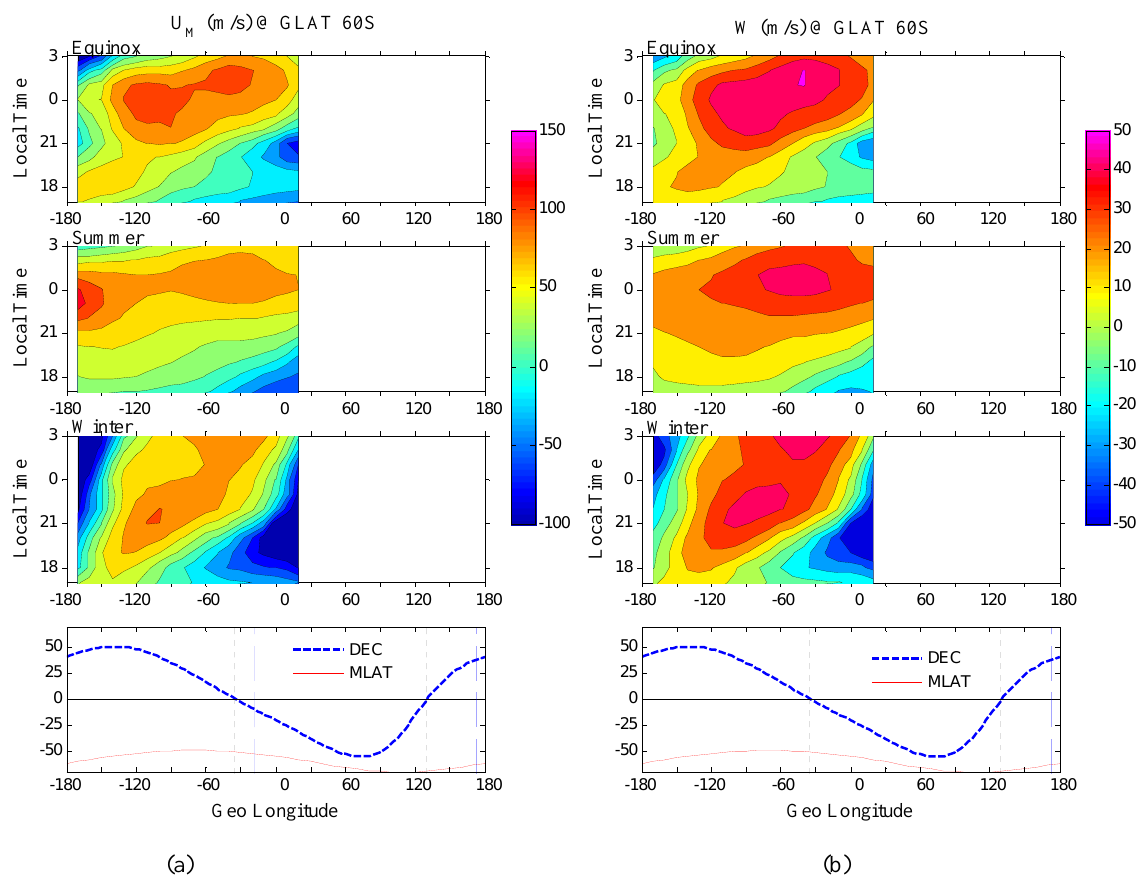
Figure 4. Similar with Figure 3, but at 60°S. Winds are absent at geomagnetic latitudes higher than 478 Fig. 4. Similar to Fig. 3 but at 60 ◦ S. Winds are absent at geomagnetic latitudes higher than 60 ◦ S, where they might be beyond the reliability of the servo 60°S, where they might be beyond the reliability of the servo method. 479